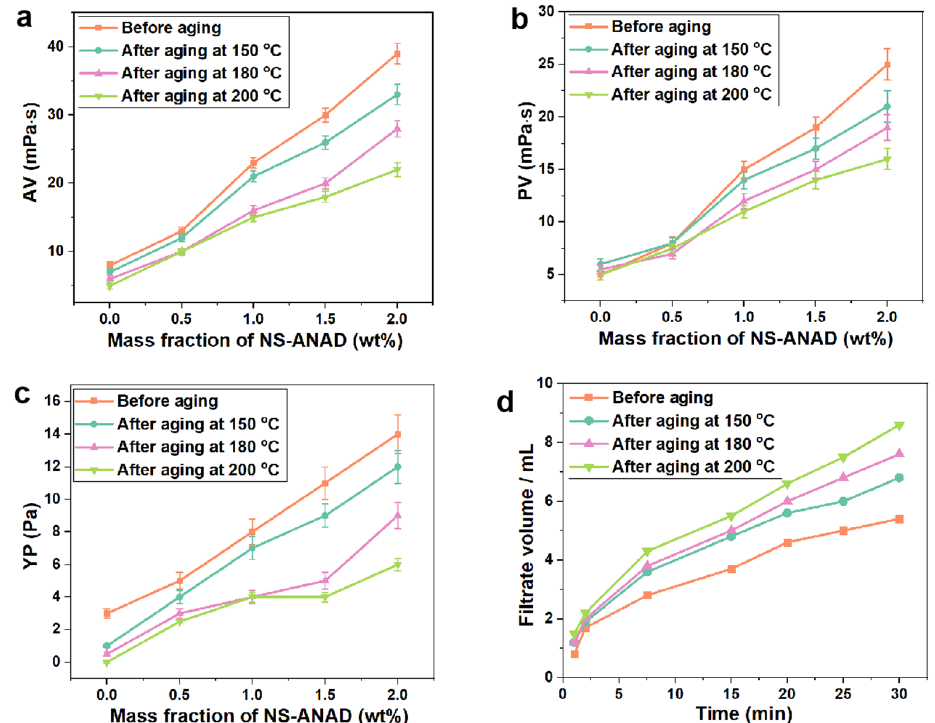
Figure 4. Rheological properties of drilling fluid with different contents of NS-ANAD co-polymer before and after aging at different temperatures for 16 h: ( a ) apparent viscosity (AV); ( b ) plastic viscosity (PV); ( c ) yield point (YP). ( d ) Fluid loss volume (FL API ) of drilling fluid with 2 wt% NS- ANAD before and after aging at different temperatures for 16 h.